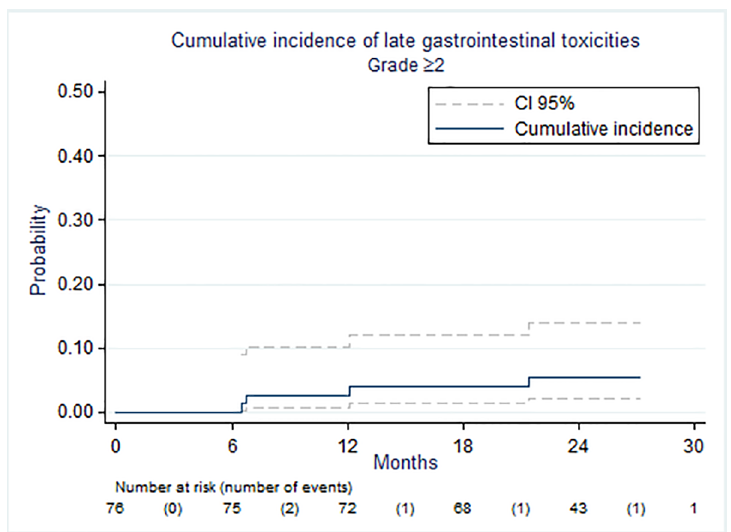
Fig 2. Actuarial cumulative incidence of grade (cid:21) 2 late gastrointestinal toxicities (CTCAE v4.0).